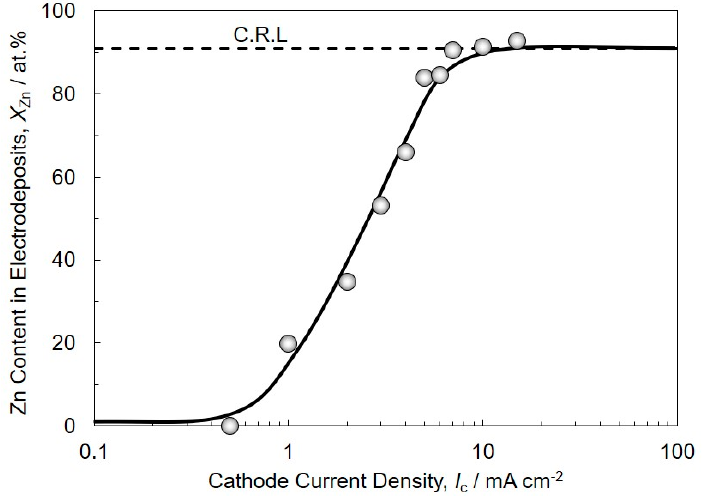
Figure 3. Effect of cathode current density on Zn content in electrodeposited Sn-Zn alloy films. Figure 3. E ff ect of cathode current density on Zn content in electrodeposited Sn-Zn alloy